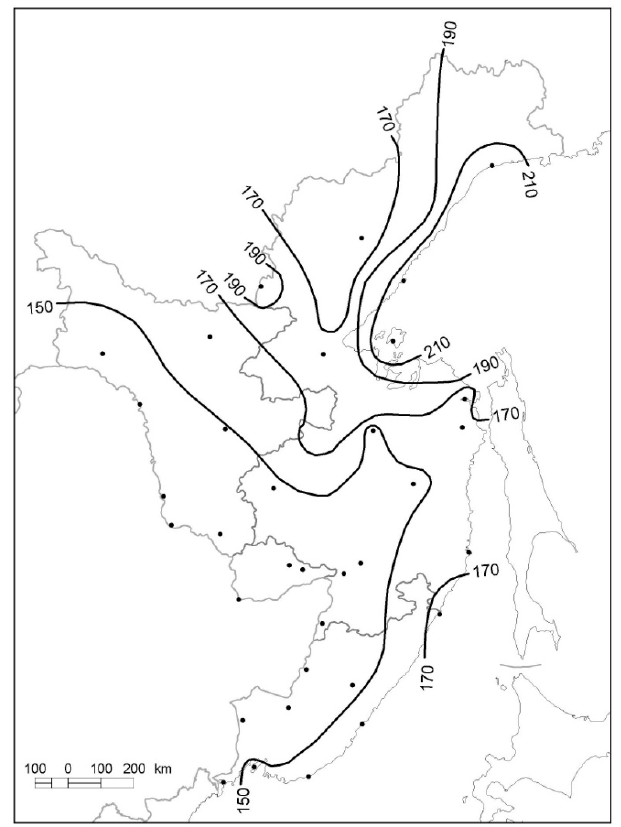
Figure 10. CCSI map for a GDD10 +3 scenario showing GDD10SI +3 for the Russian Far East study area, where GDD10SI +3 = GDD10 +3 /GDD10 × 100. The areas bounded by isolines indicate zones of increasing sensitivity expressed as the percentage change in GDDs10 brought about by the changed climatic conditions.